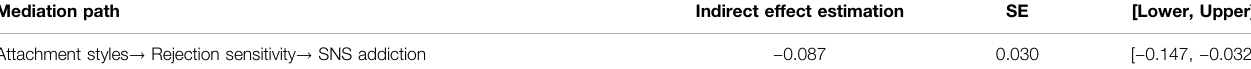
TABLE 3 | Multiple mediating effects and 95% con fi dence intervals (N (cid:1) 607). Mediation path